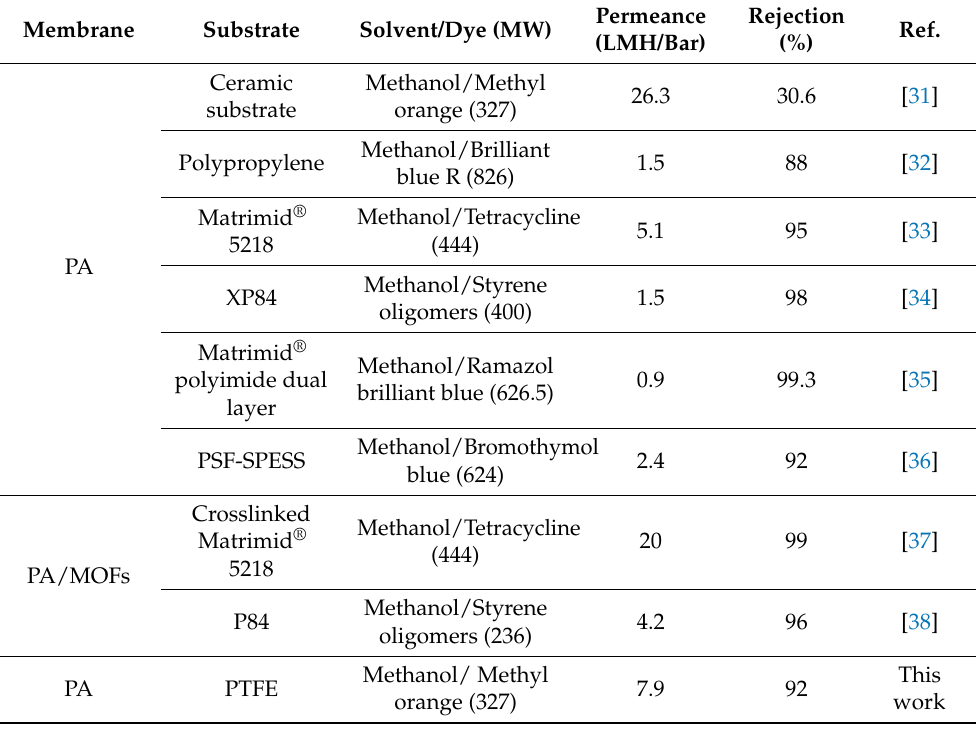
Figure 9. Long-term performance of the TFC PA-3 membrane for the separation of a 20 ppm MO/MeOH solution at 6 bar and 25 °C (one membrane coupon for all measures). Table 4. Comparison of the performance of our TFC PA OSN membrane with other TFC PA OSN membranes reported in the literature.